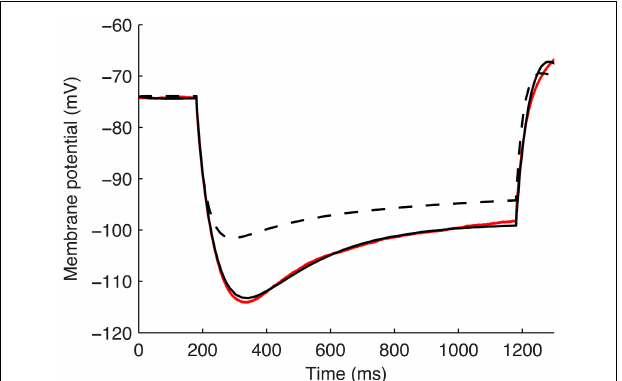
FIGURE 5 | Example model’s somatic membrane potential before and after optimizing the passive properties and I h characteristics. Voltage traces showing experimental cell 4425#4 (solid red), model S3 with original parameters from highly-ranked database in Sekuli´c et al. (2014) (dashed black), and model S3 with optimized R m , C m , I h activation time constant parameters t 1 , t 2 , ..., t 8 , and dendritic scaling factor k d for linear dendritic distribution of G h (solid